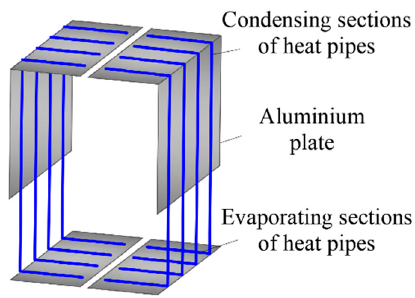
Appl. Sci. 2020 , 10 , x FOR PEER REVIEW Figure 2. Structural schematic of the heat pipes. Figure 2. Structural schematic of the heat pipes. Figure 2. Structural schematic of the heat pipes.